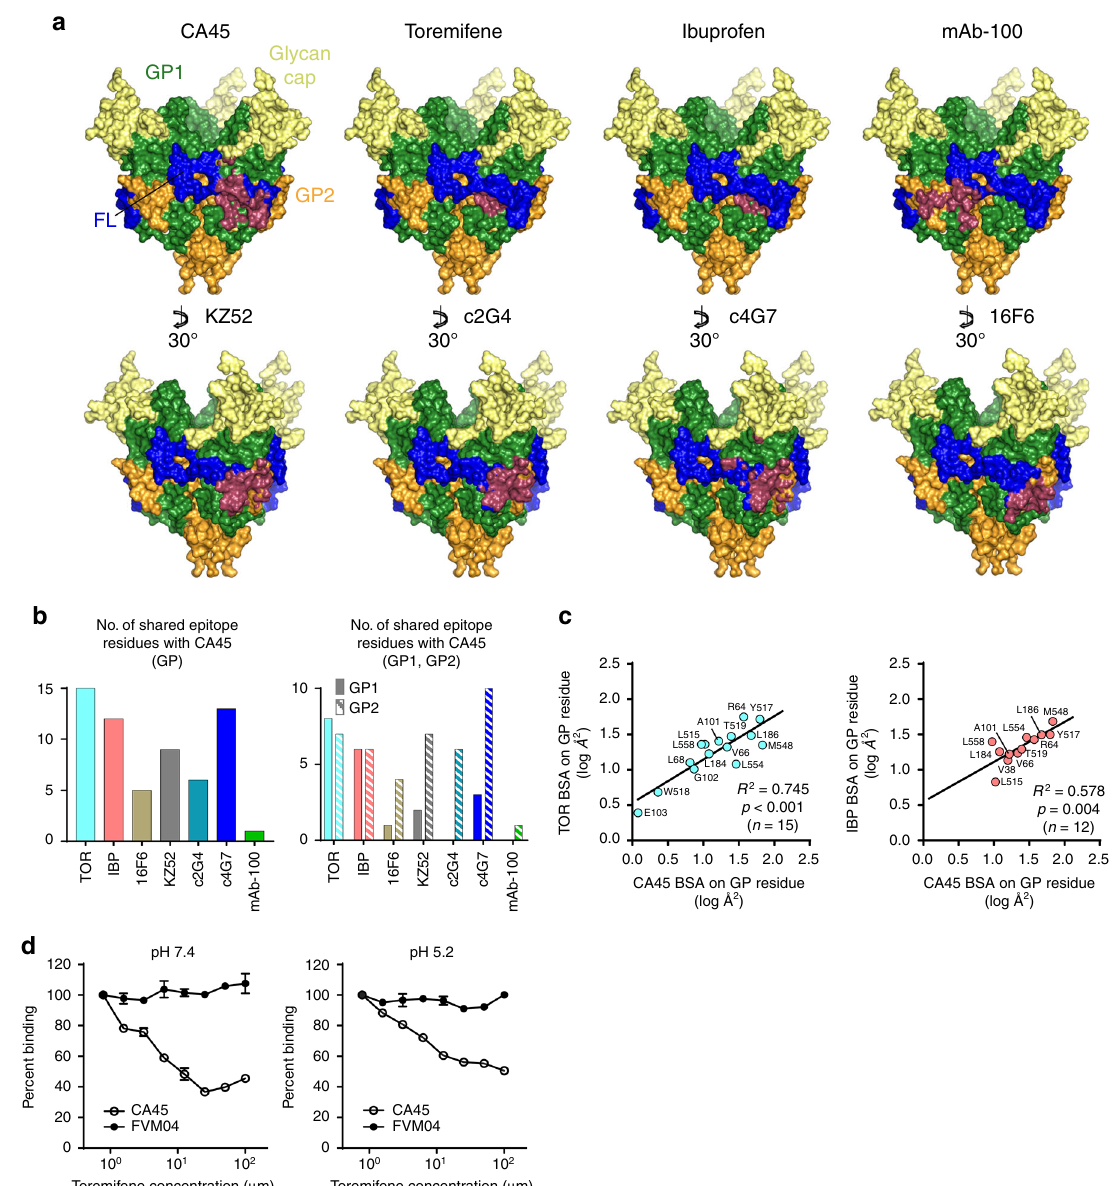
Fig. 4 Comparison with other neutralizing antibodies and inhibitors that target the GP1 – GP2 interface. a Epitope footprints of antibodies and small-molecule inhibitors that target the GP1 – GP2 interface mapped onto the surface of the CA45-bound EBOV GP Δ Muc trimer. Footprints of each respective ligand colored raspberry. Lower panels rotated by 30° relative to CA45 panel. b Comparison of number of shared epitope residues with CA45, total (left) and by GP subunit (right) . c Pairwise linear regressions of log transformed buried surface areas (BSA) of shared GP interface residues of CA45 with toremifene (TOR; left) and ibuprofen (IBP; right). Statistical correlations were determined under the null hypothesis of zero correlation against the alternative hypothesis of non-zero correlation. R 2 , coef fi cient of determination; p , p -value; n , sample size. d ELISA competition analysis of toremifene against neutralizing antibodies CA45 and FVM04 for binding to recombinant EBOV GP Δ Muc, at pHs 7.4 and 5.2. Data were normalized to percent binding relative to no competitor control and error bars represent SD of sample duplicates from plotted